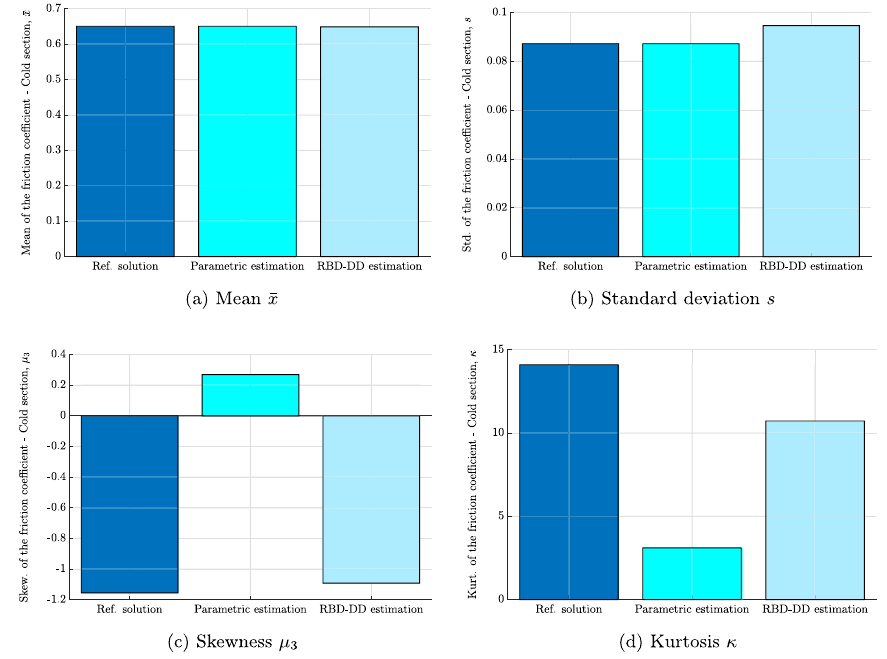
Fig. 2 The first four statistic moments for the friction coefficient of the cold section: a mean value, b standard deviation, c skewness and d kurtosis. The four statistic indicators are computed directly from (i) the measured data using Eqs. (35), (36), (37) and (38) (the reference solution), (ii) the parametric estimation using the fitted Gamma PDF and (iii) the reconstructed PDF based on the RBD-DD random generator